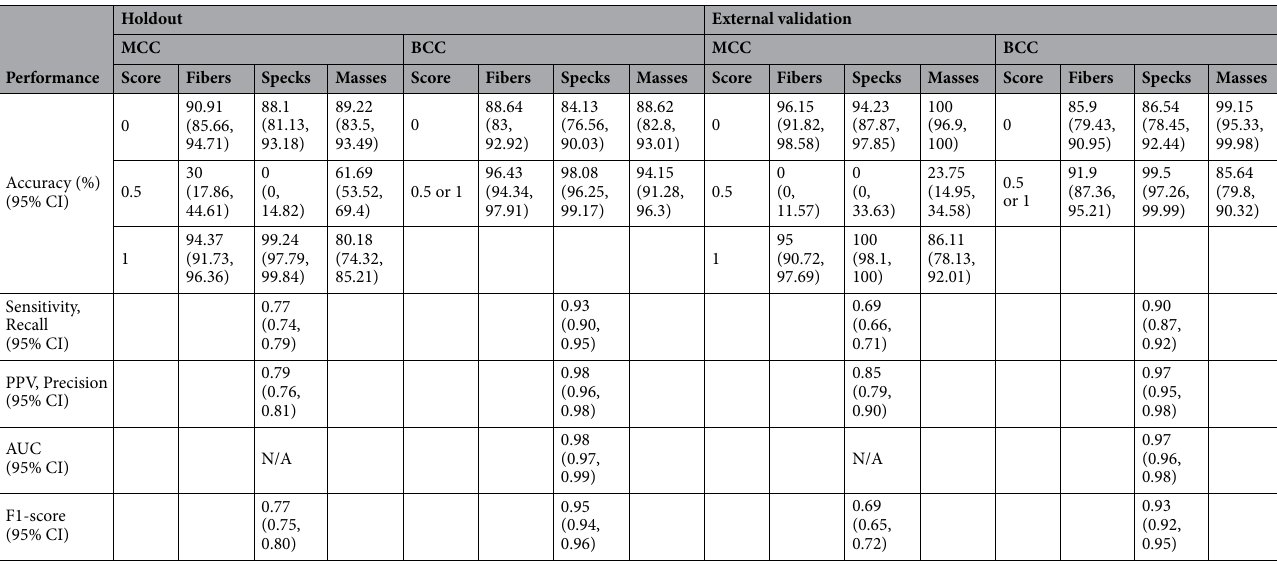
Table 4. Performance of the DPS models in the holdout and external validation set. DPS, deep neural network based phantom shape scoring; MCC, multi-class classifier; BCC, binary-class classifier; PPV, positive predictive value, N/A, not applicable; AUC, area under receiver operating characteristic